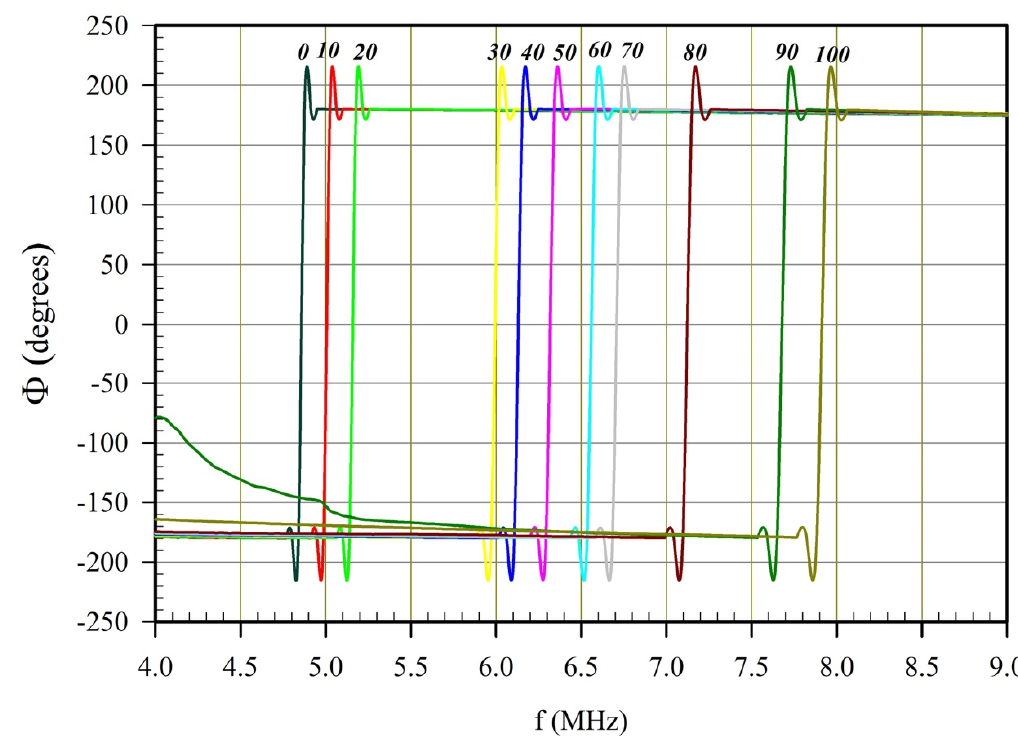
Figure 5. Peak phase shift vs. frequency as detected by the Gain-Phase Analyzer at different Glycerin concentrations (0 to 100%).